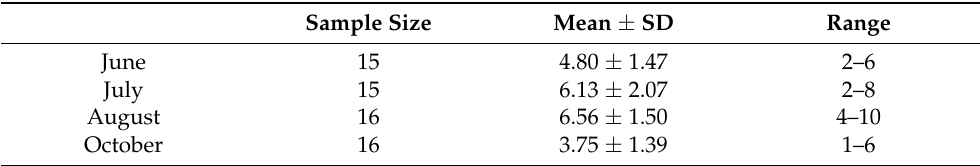
Table 3. Sample sizes (the number of Eastern Box Turtles sampled) and associated means and standard deviations of the number of diet categories for which prey species were detected in the feces of individual